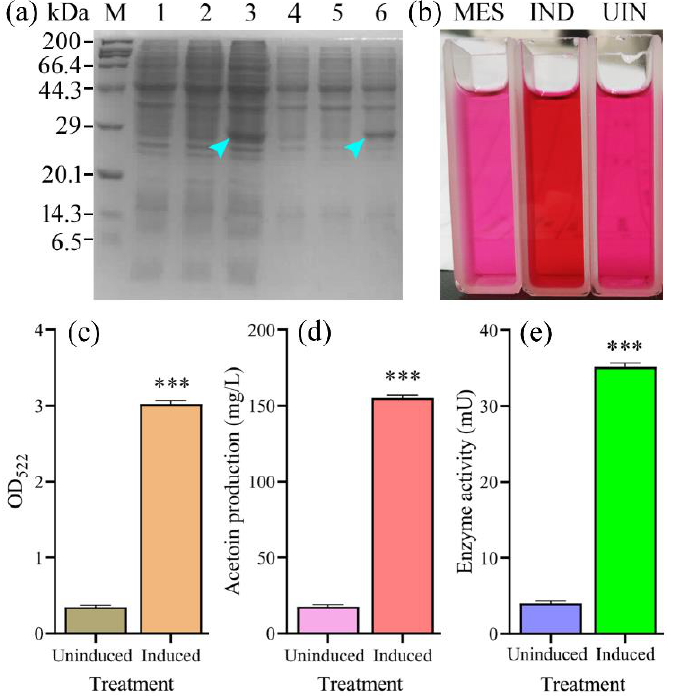
Figure 3. SDS‒PAGE and enzymatic analyses of recombinant ALDC. ( a ) SDS‒PAGE analysis. M, protein molecular weight marker; Lanes 1–3, proteins from cell pellet; Lanes 4–6, proteins from su- pernatant; Lanes 1 and 4, proteins from NZ9000/pNZ8048; Lanes 2 and 5, proteins from NZ9000/pNZ8048- aldC without nisin induction; Lanes 3 and 6, proteins from NZ9000/pNZ8048- aldC with nisin induction; arrows, target protein bands. ( b ) The result of the chromogenic reaction. MES, MES buffer used for zeroing; IND, NZ9000/pNZ8048- aldC with nisin induction; UIN: NZ9000/pNZ8048- aldC without nisin induction. ( c ) The OD 522 of NZ9000/pNZ8048- aldC with or without nisin induction. ( d ) The acetoin production of NZ9000/pNZ8048- aldC with or without nisin induction. ( e ) The enzyme activity of NZ9000/pNZ8048- aldC with or without nisin induction. Data are presented as the mean ± SD. *** indicates a significant difference ( p < 0.001). 3.3. Optimizing the Concentration of Nisin to Increase ALDC Expression The results of the WB experiment showed that the expression of ALDC first increased and then decreased with increasing nisin intensity, and the maximum expression ap- peared when the concentration of nisin was 20 ng/mL (Figure 4). The effect of nisin con- centration on L. lactis recombinant protein expression has been discussed in many studies. Bahey et al. [19] reported that 0.2% ( v / v ) nisin (filter-sterilized culture supernatant of the nisin-secreting strain L. lactis NZ9700 was used as a source of nisin) was chosen for 4 h induction to maximize Listeriolysin O production. Van Hoang et al. [20] reported that the maximal expression of recombinant T-cell epitope peptide was achieved with 40 ng/mL nisin induction for 4 h at 30 °C. In this study, 20 ng/mL nisin was selected for subsequent experiments. Figure 4. Effect of nisin concentrations on ALDC expression.